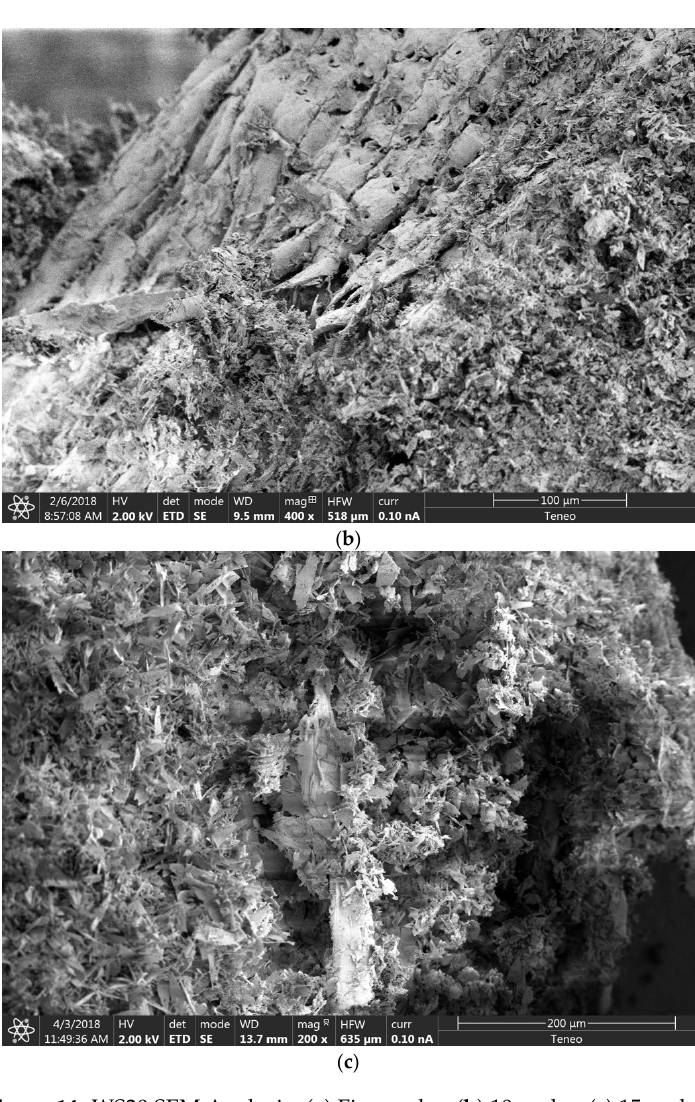
Figure 14. WS20 SEM Analysis. ( a ) Five cycles; ( b ) 10 cycles; ( c ) 15 cycles. Materials 2019 , 11 , x FOR PEER REVIEW